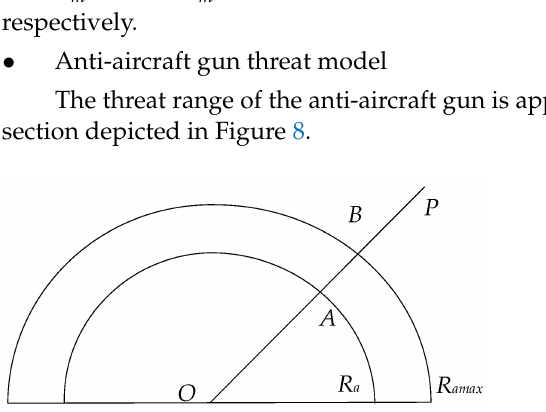
Figure 8. Horizontal section of anti-aircraft gun threat